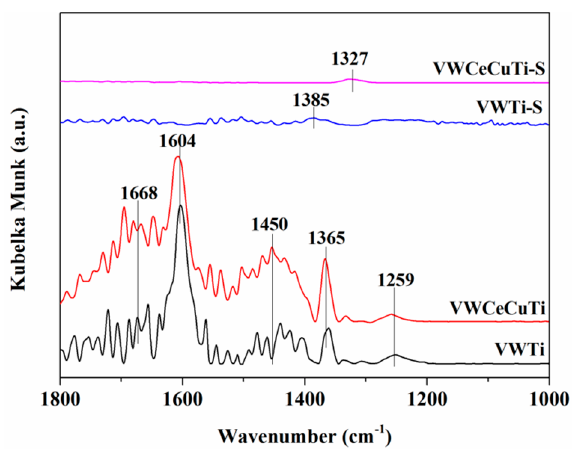
Figure 6. In situ DRIFT spectra of NH 3 adsorption over fresh and S-poisoned samples at 250 °C.